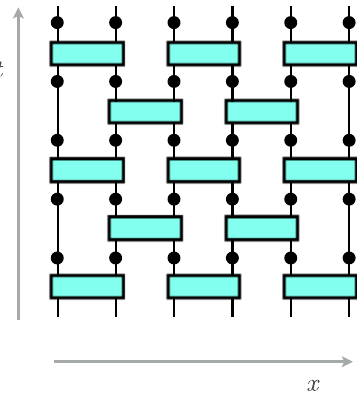
FIG. 3. Circuit representation for evolution of the quantum system. Bricks indicate unitary operators (specified in the text). Dots indicate spacetime locations where measurements may take place. Note that the full dynamics is nonlinear since the state must be renormalized after each projective measurement